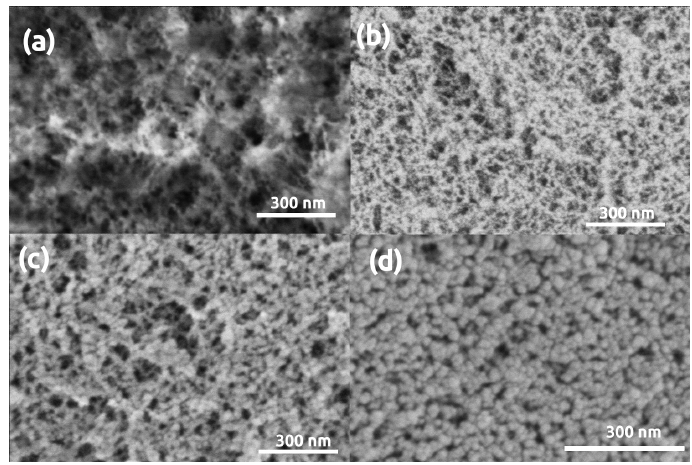
Figure 2. LVSEM images of silica-casein aerogel samples. ( a ) Pristine, uncoated. ( b – d ) Sputter coated with 5 nm, 16 nm, 32 nm thick Au layers, respectively.